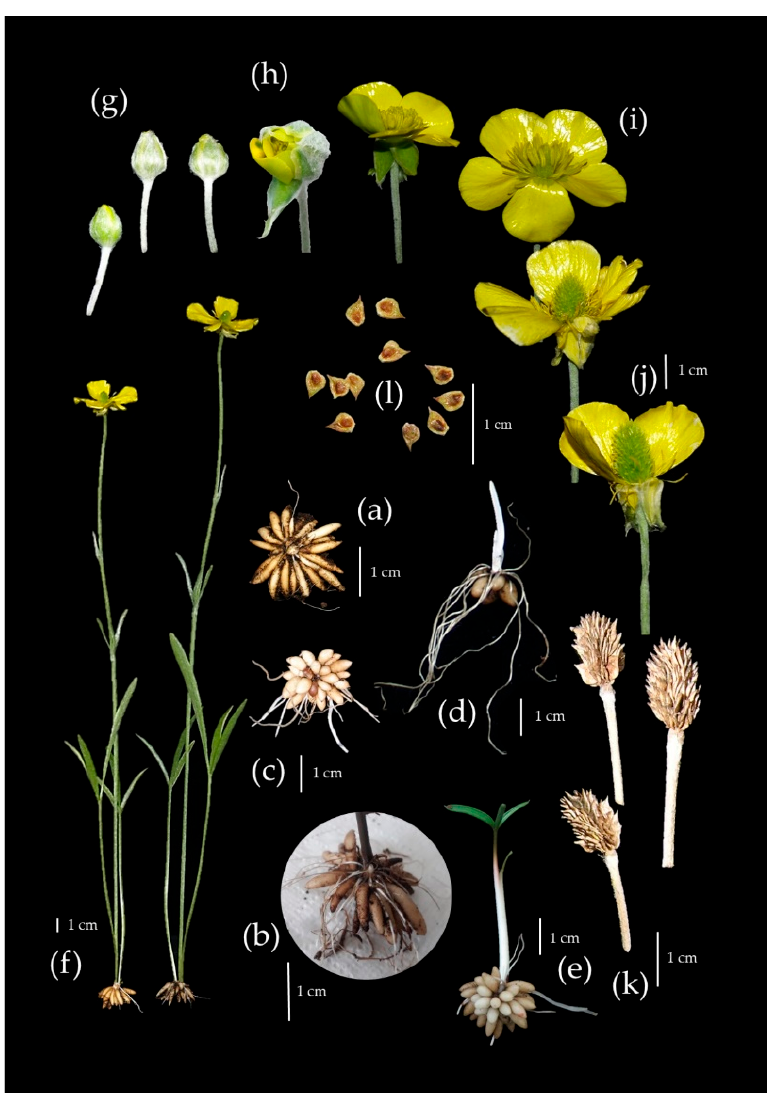
Figure 2. Annual developmental cycle of Ranunculus illyricus : ( a ) dormant cluster of tubers, ( b – d ) development of underground parts and ( e ) shoot with leaf after dormancy, ( f ) flowering plants, ( g – j ) developmental stages of flower, ( k ) receptacle with achenes, ( l ) ripe fruits.